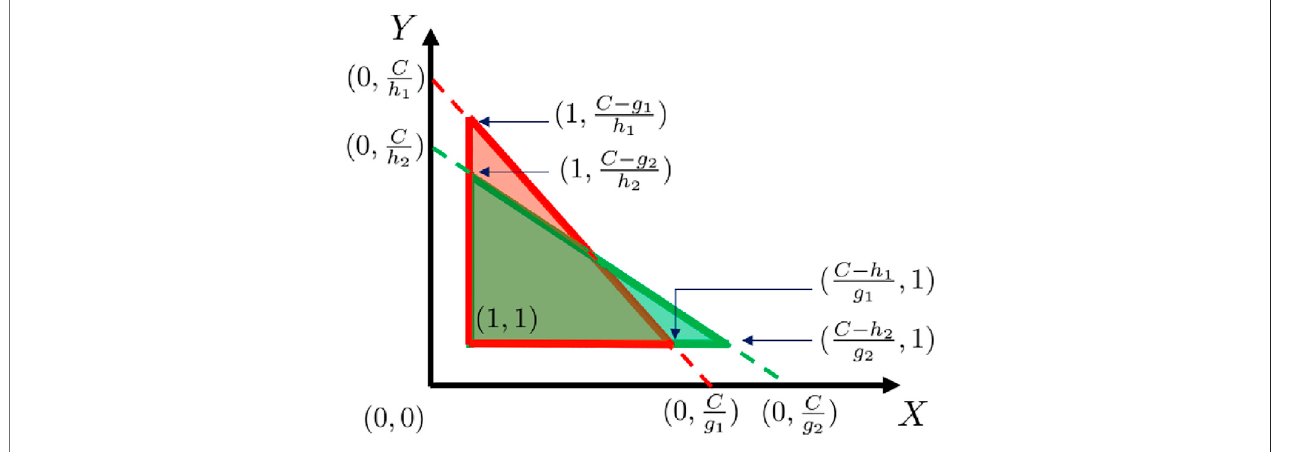
(cid:22)(cid:22)(cid:22)(cid:22) h 1 y + g 1 x < C , x ∈ [ 1 , H max , y ∈ [ 1 , H max ]]} , and the green triangle is